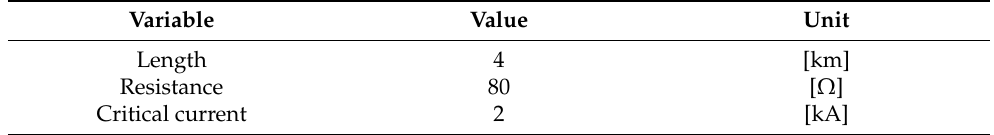
Table 4. RQ model settings for HVDC